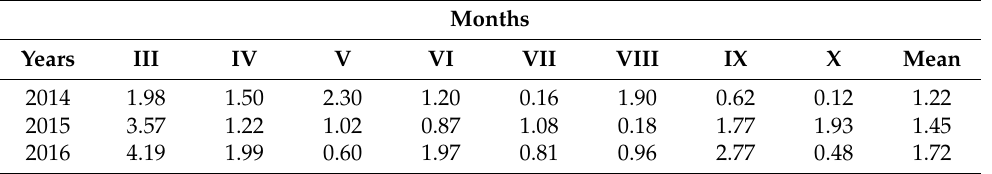
Table 2. Sielianinov’s hydrothermal index K (mm/ ◦ C).